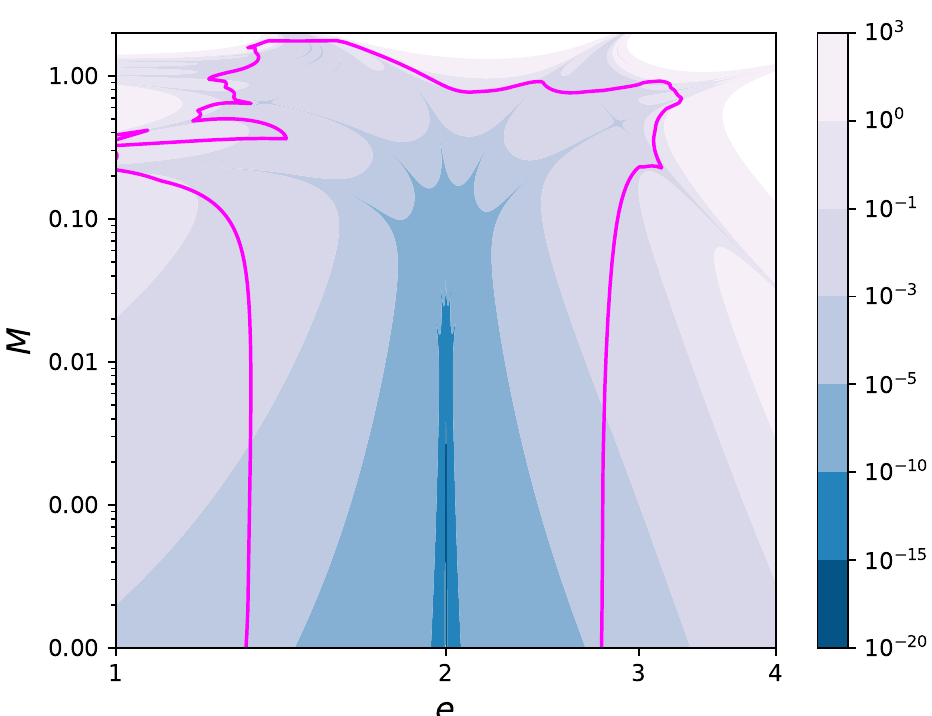
Figure 4. Contour levels of the error E 5 affecting the fifth degree polynomial approximation of Equation (31), as a function of the eccentricity e and the mean anomaly M (both in logarithmic scale). The continuous magenta curve marks the boundary of the region of convergence, as estimated with Equations (20) and